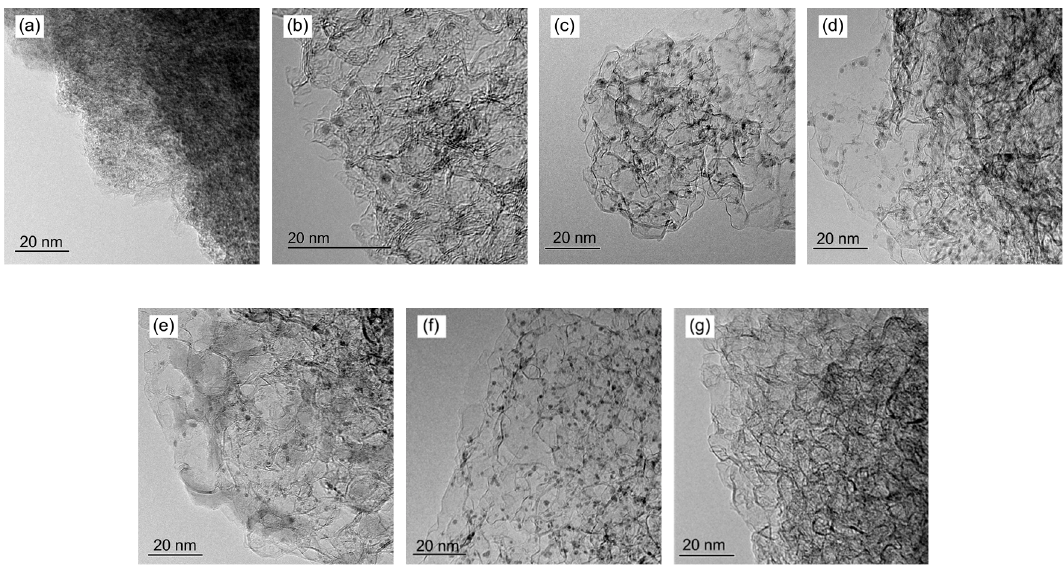
Figure 3. HRTEM images of the prepared Ba-Ru catalysts and reference materials: ( a ) 1.6Ba-10Ru / AC, ( b ) 1.6Ba-10Ru / MPC, ( c ) 1Ba-10Ru / MPC, ( d ) 0.5Ba-10Ru / MPC, ( e ) 0.1Ba-10Ru / MPC, ( f ) 10Ru / MPC, and ( g ) 1.6Ba / MPC.